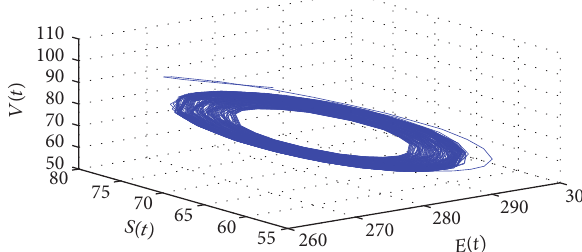
Figure 11: The projection of the phase portrait of system (69) in (𝑆, 𝐸,𝑉) -space with 𝜏